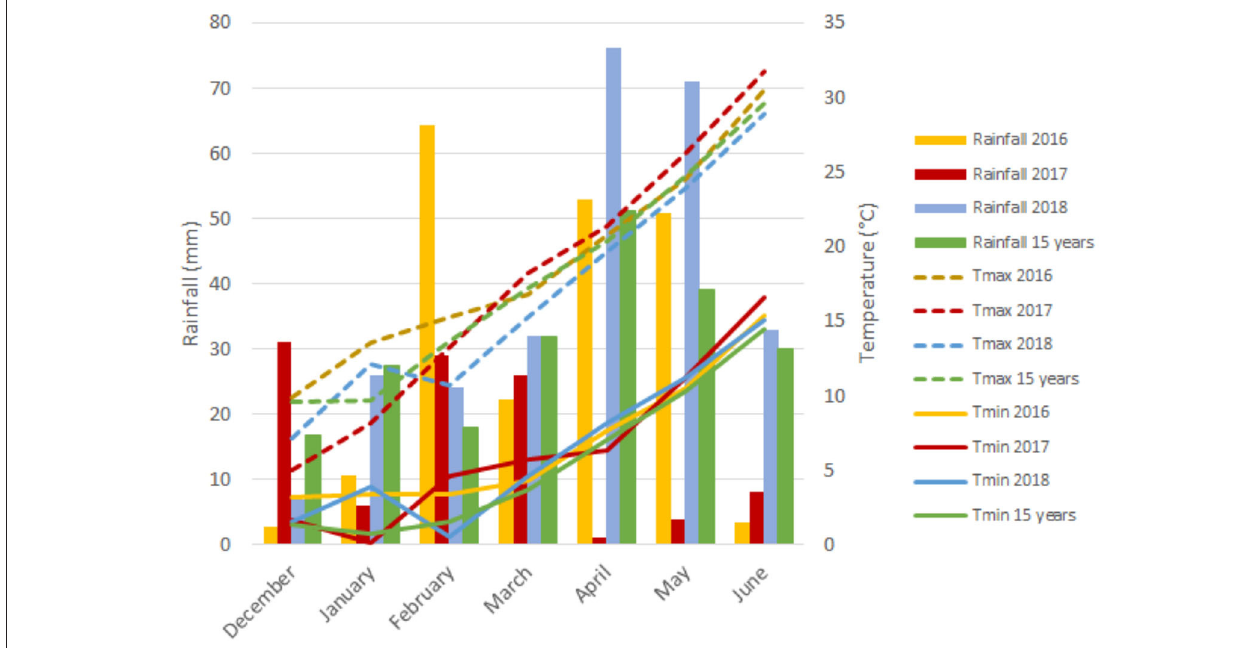
FIGURE 1 | Monthly rainfall (mm) and minimum (Tmin) and maximum (Tmax) temperatures during the growth cycle of each growing season.